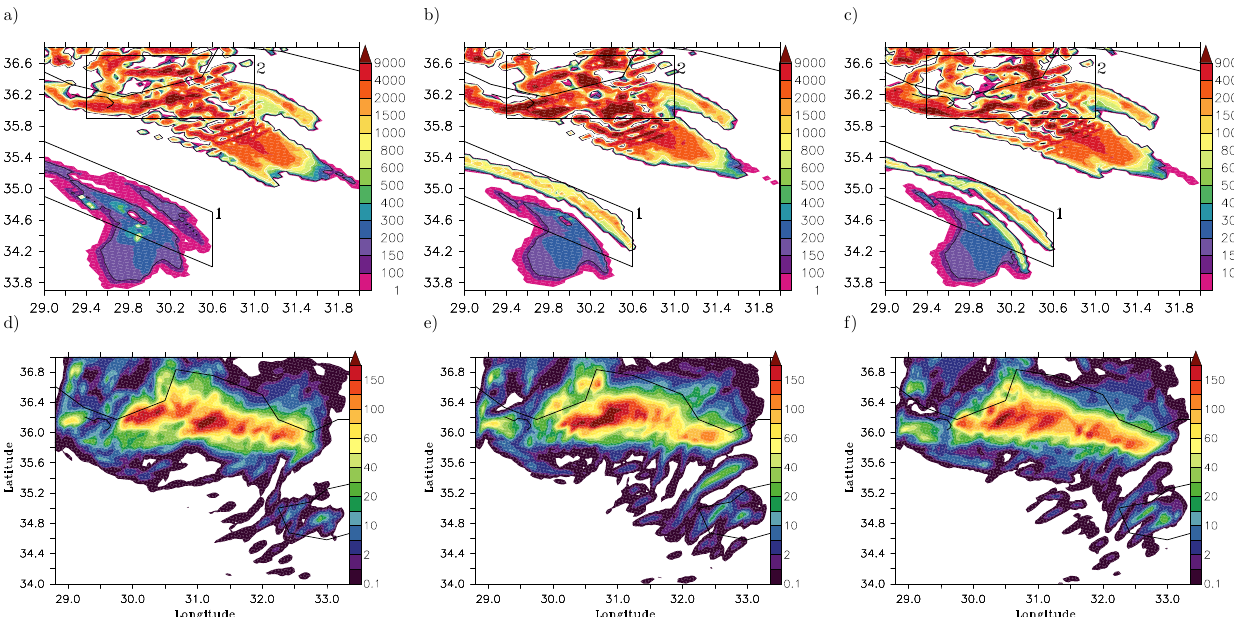
Fig. 2. (a–c) show the column burden of the cloud droplet number concentrations (10 8 m − 2 ) at 15:00UTC for the scenarios: (a) NOdust (b) τ 1 (c) τ 48 (4km domain). (d–f) show 24h accumulated precipitation (mm) again for scenarios (d) NOdust (e) τ 1 (f) τ 48